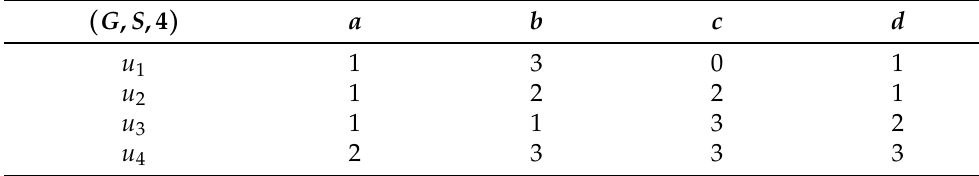
Table 3. The 4-Soft Set of ( G , S ,4 )